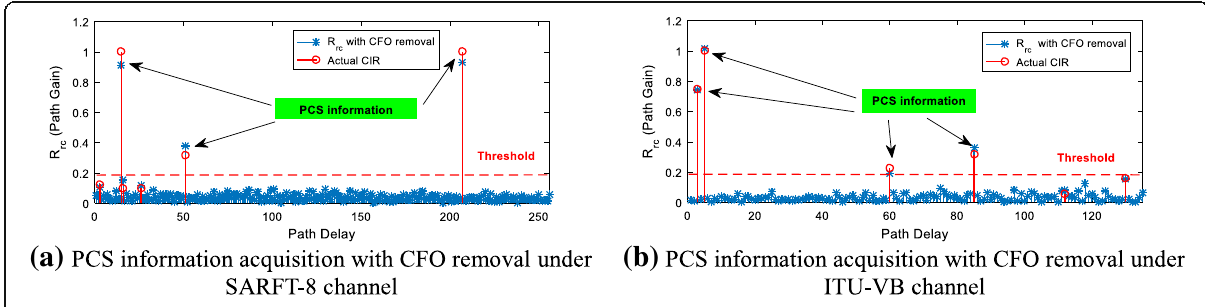
Fig. 6 PCS information acquisition with CFO removal in 16 × 16 MIMO-OFDM system with f max = 20 HZ, f c = 0.05, and SNR = 5